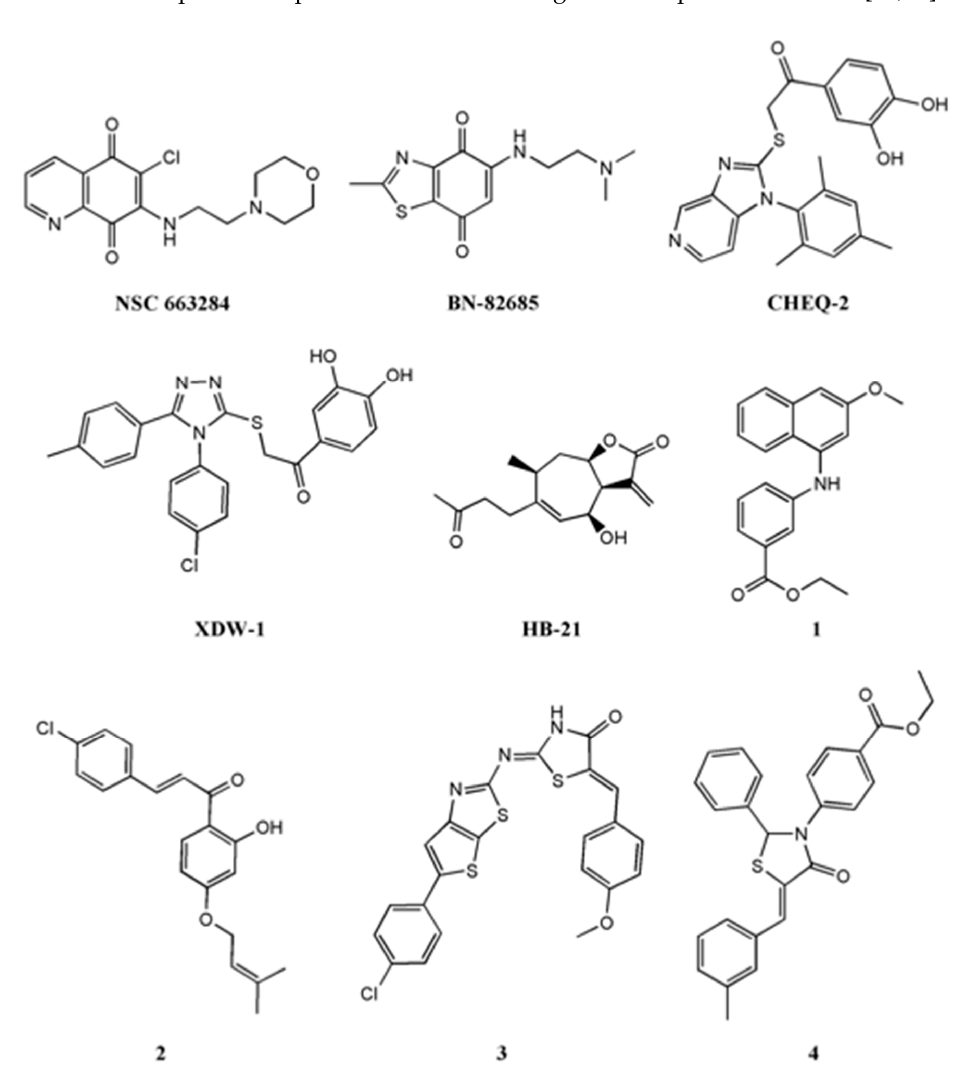
Figure 3. The chemical structure of some well-known Cdc25 inhibitors.